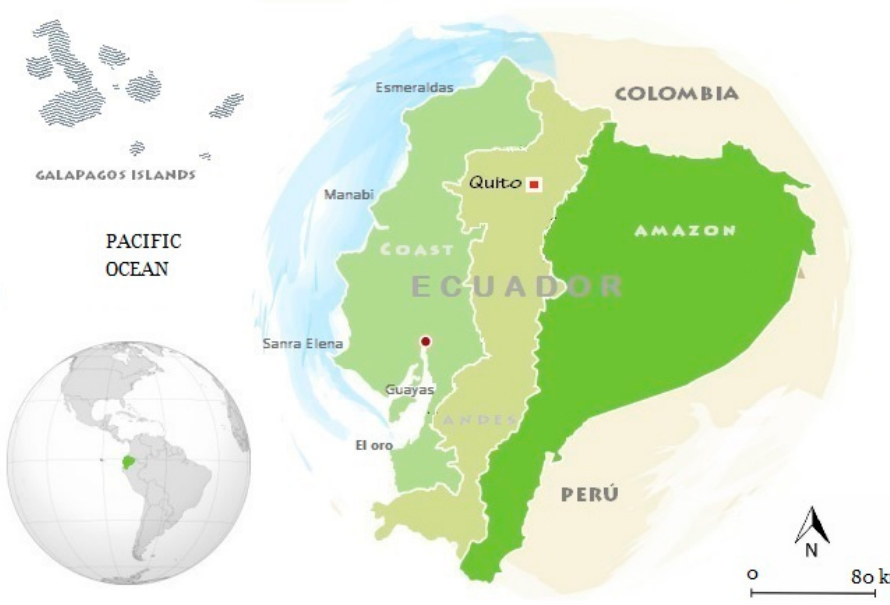
Figure 2. Map of Ecuador, study area.